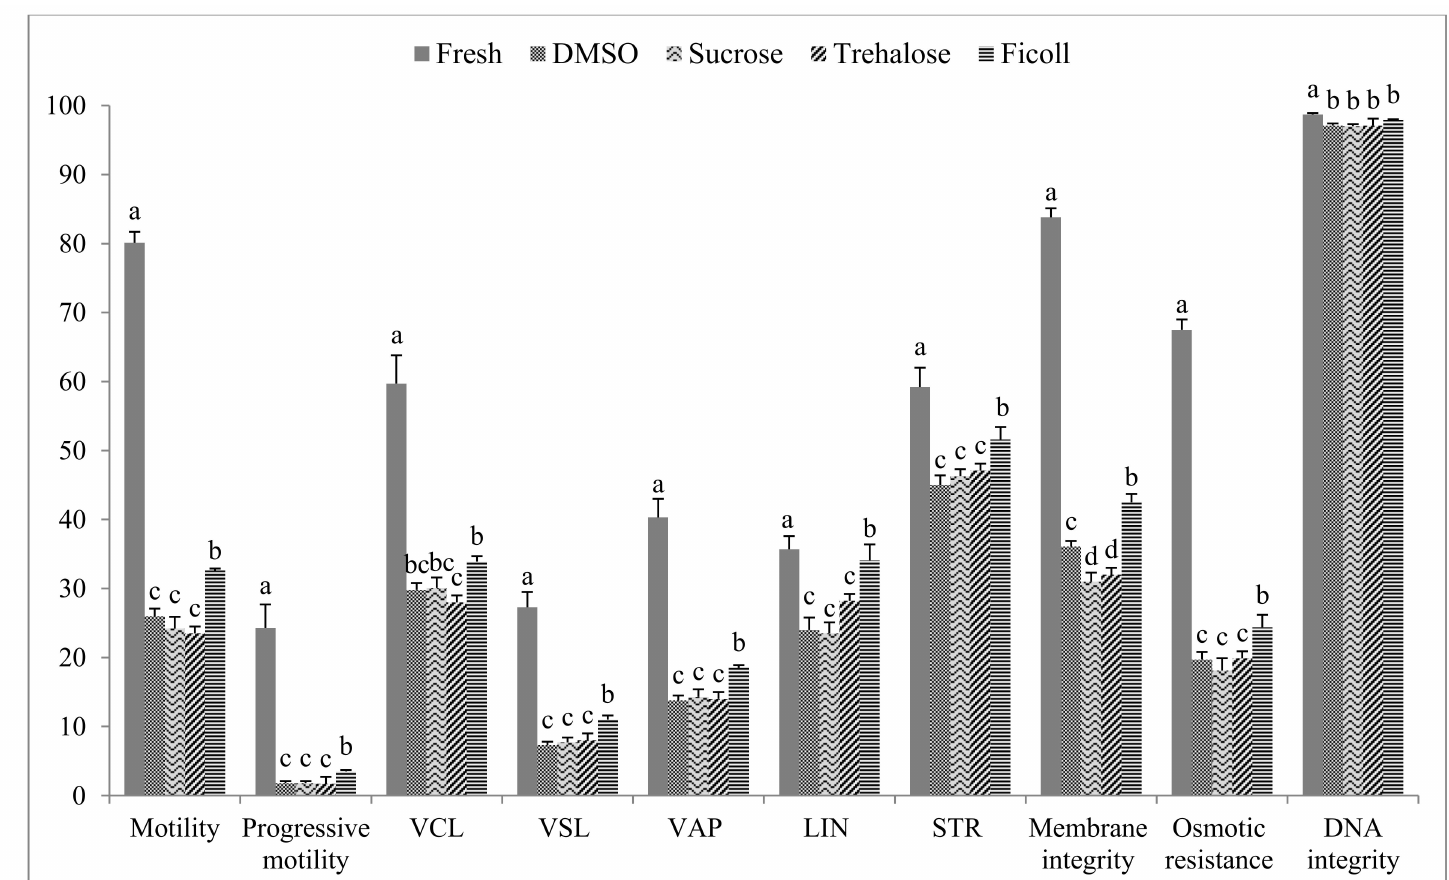
Figure 2. Comparison of semen quality measured in fresh and frozen / thawed semen considering the best freezing protocol identified for each CPA tested (N = 8). a–d Di ff erent superscripts letters within each semen parameter indicate a significant di ff erence ( p < 0.05). Motility (%); Progressive motility (%); VCL: curvilinear velocity ( µ m / s); VSL: straight-line velocity ( µ m / s); VAP: average path velocity ( µ m / s); LIN: linearity (%); STR: straightness (%); Membrane integrity (%); Osmotic resistance (%); DNA integrity